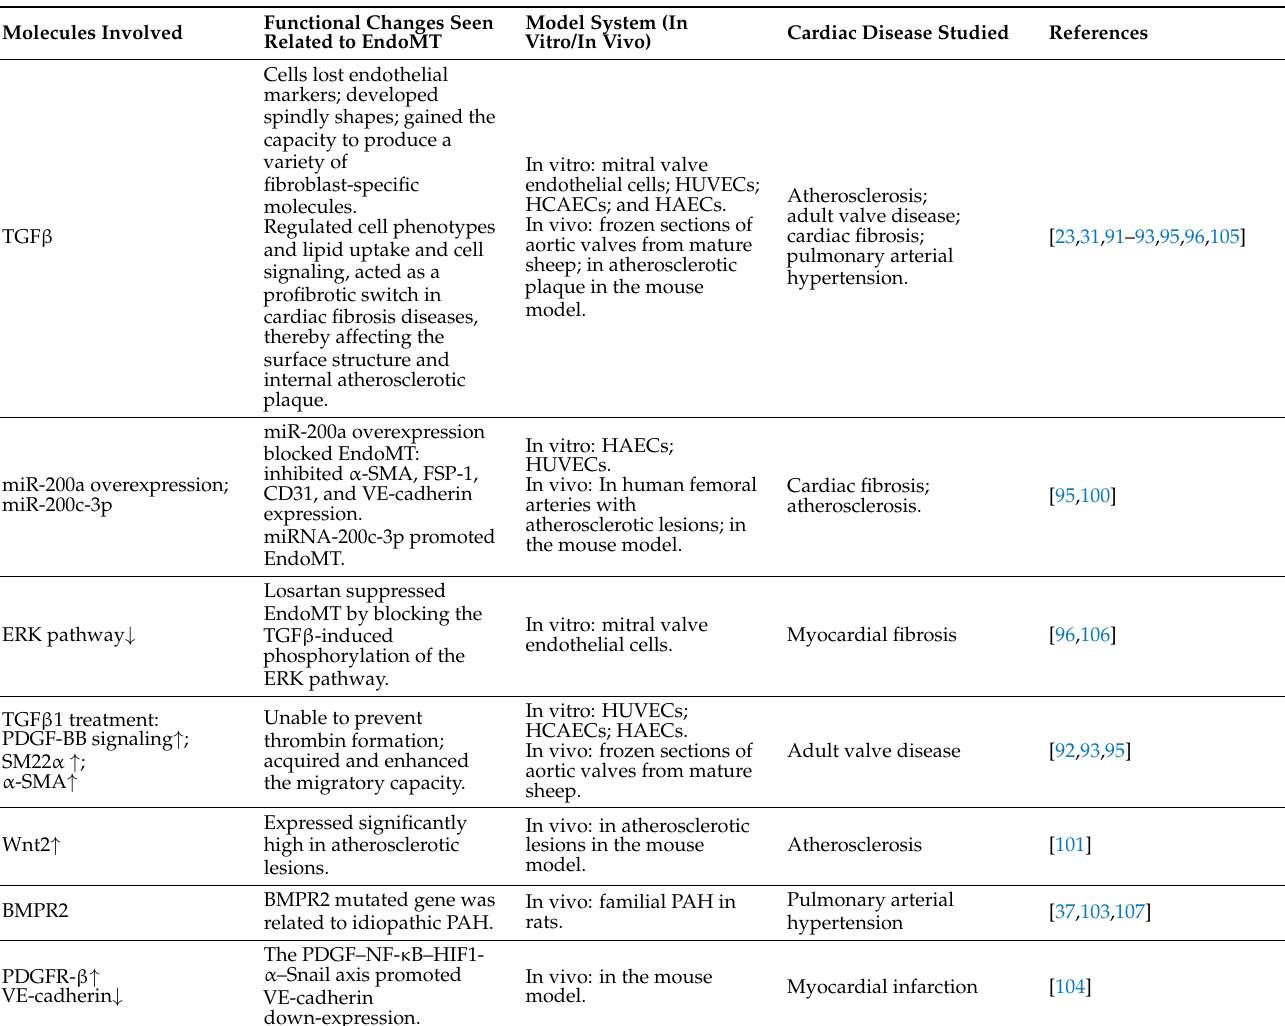
Table 1. EndoMT in in vitro and in vivo